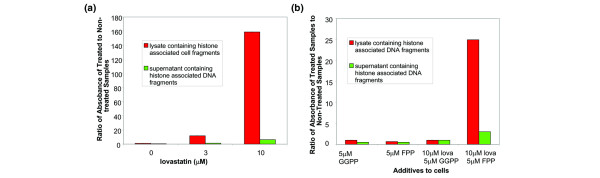
Cellular lysates of synovial fibroblasts cultured in lovastatin contain histone-bound DNA fragments. Cell lysates and corresponding culture supernatants were assayed by Cell Death Detection ELISAPLUS for the presence of histone-bound DNA fragments. (a) Synovial fibroblasts were cultured for 72 hours in the presence of 0, 3 or 10 μM lovastatin. The dark bars represent fragments present in the cell lysate indicative of apoptosis; the light bars represent fragments present in the supernatant. Shown is a representative of three different experiments. (b) Synovial fibroblasts were cultured for 72 hours in 10 μM lovastatin supplemented or not with 5 μM farnesylpyrophosphate (FPP) or 5 μM geranylgeranylpyrophosphate (GGPP).